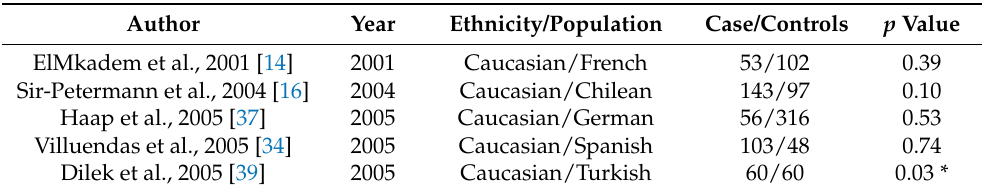
Table 6. Comparison of the present study with previous studies of IRS-1 gene Gly972Arg polymor- phism in